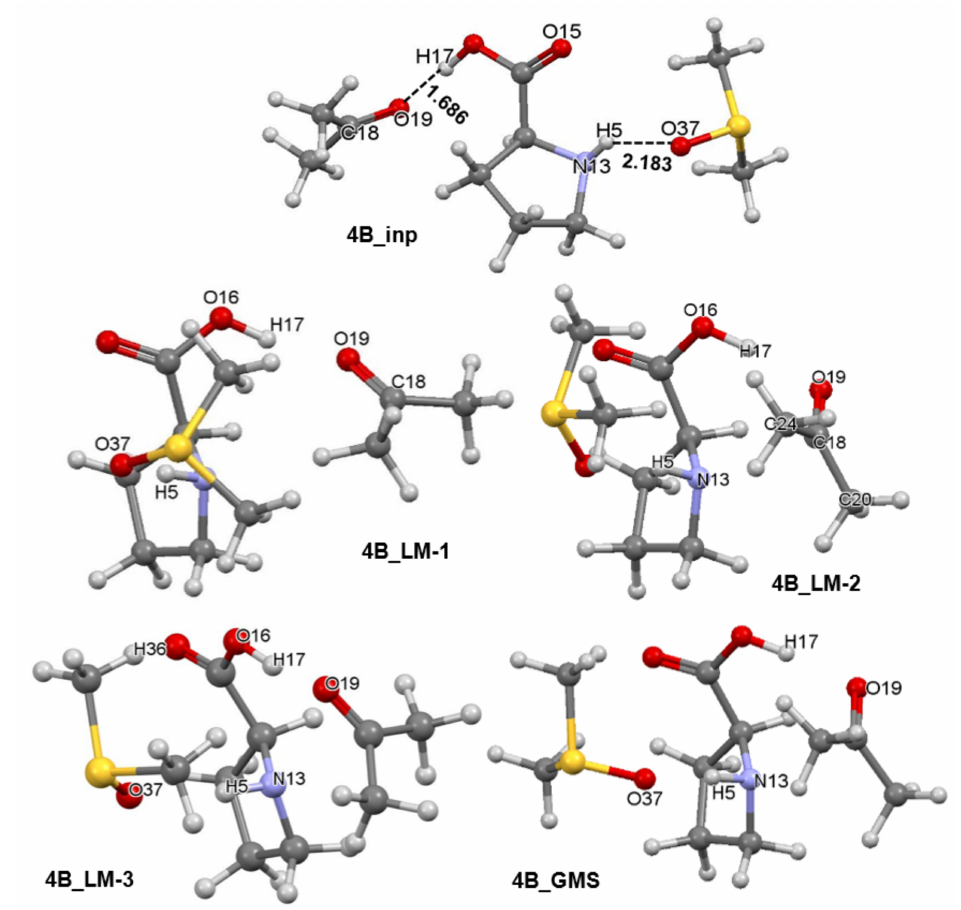
Figure 6. Ball-and-stick representation of 3-MCs showing the initial structure ( 4B_inp ), intermediate three local minimum structures ( 4B_LM ), and the global minimum energy 3-molecular complex discovered ( 4B_GMS ). They all consist of the HEC of proline 1b , a molecule of acetone 2 , and an explicit DMSO solvent molecule 3 .